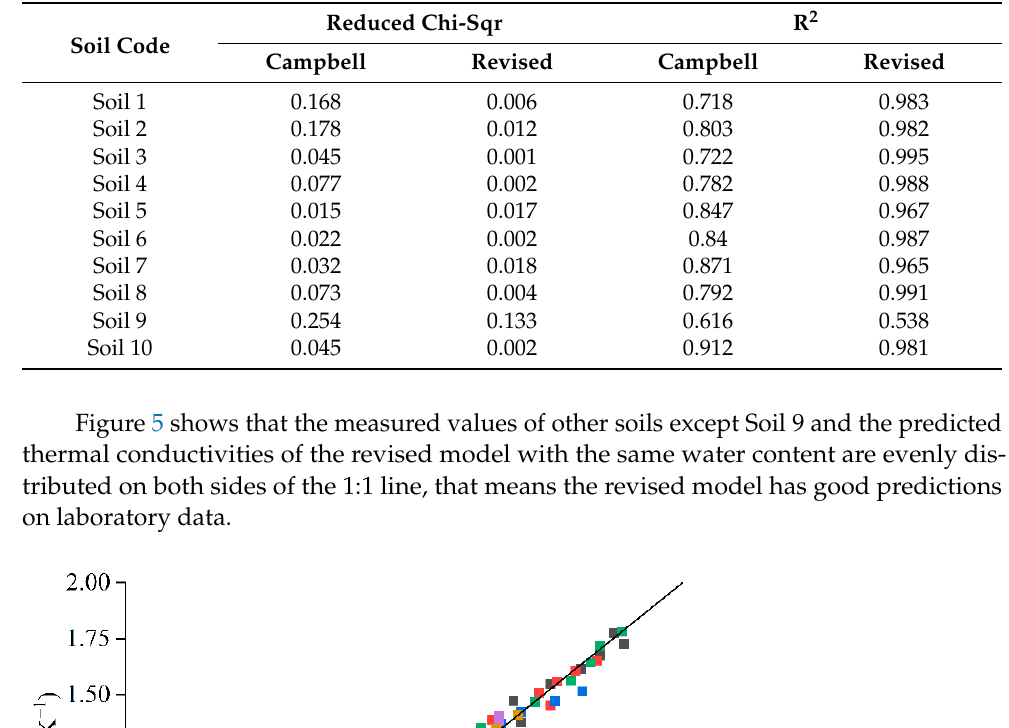
Table 7. Comparison of the reduced Chi-Sqr and R 2 of the Campbell model and the revised model on the measured soil in Table 1.